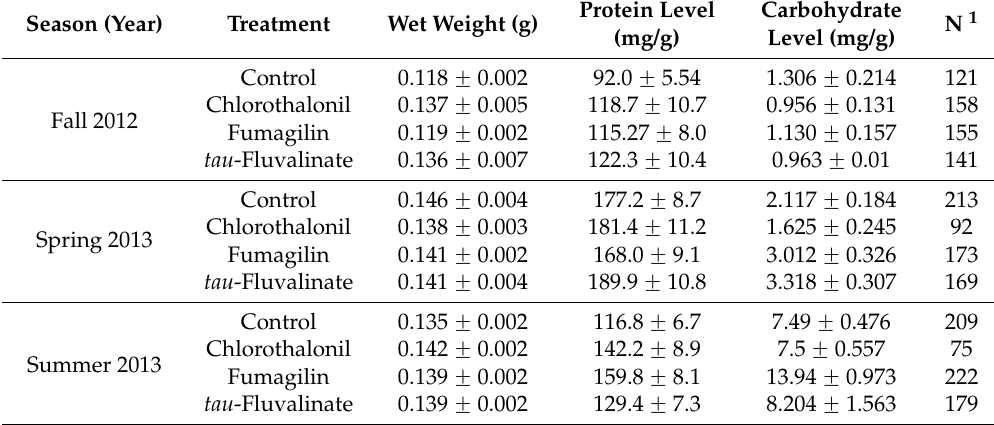
Table 1. Mean ( ˘ standard error) wet weight and macromolecule levels for worker honey bees treated with the one of four treatments (three pesticides and a control) in the fall, spring, and